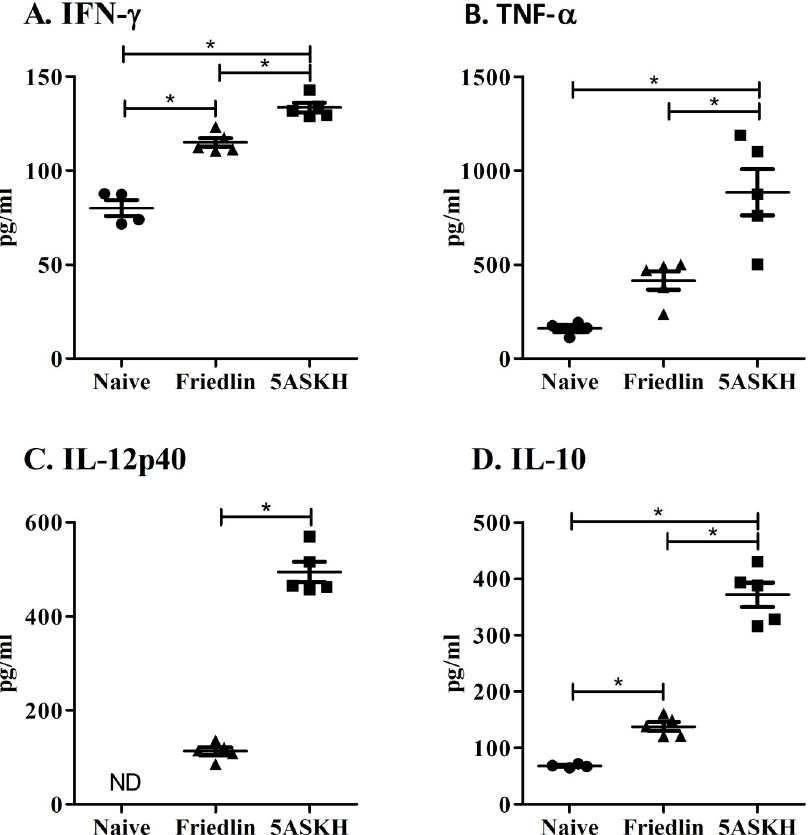
Fig 5. Lower activation of host immune responses by L . major Friedlin infection. Rag2 KO C57BL/6 mice were infected with 5 × 10 6 stationary phase promastigotes of L . major Friedlin or 5ASKH subcutaneously into the hind footpad. At 4 weeks post-infection, cells from mouse footpads were isolated and cultured for 3 days. Culture supernatants were analyzed for (A) IFN- γ , (B) TNF- α , (C) IL-12p40, and (D) IL-10 cytokines by ELISA. Three–four mice per group. Data are the mean ± SEM. � , P <